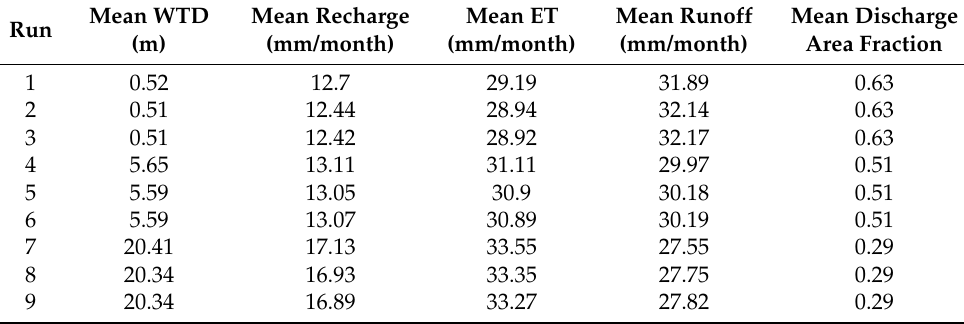
Table 2. Mean annual water table depth (WTD), model fluxes, and discharge area fraction for Runs 1–9 on the 0.05 ◦